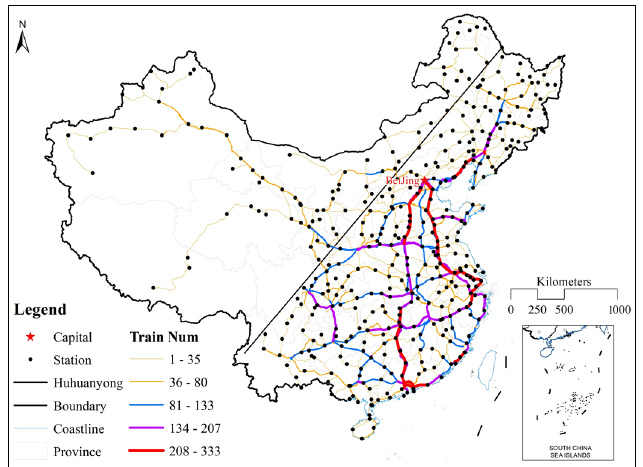
Figure 4. The Number of Train-Passing Points on the Railway